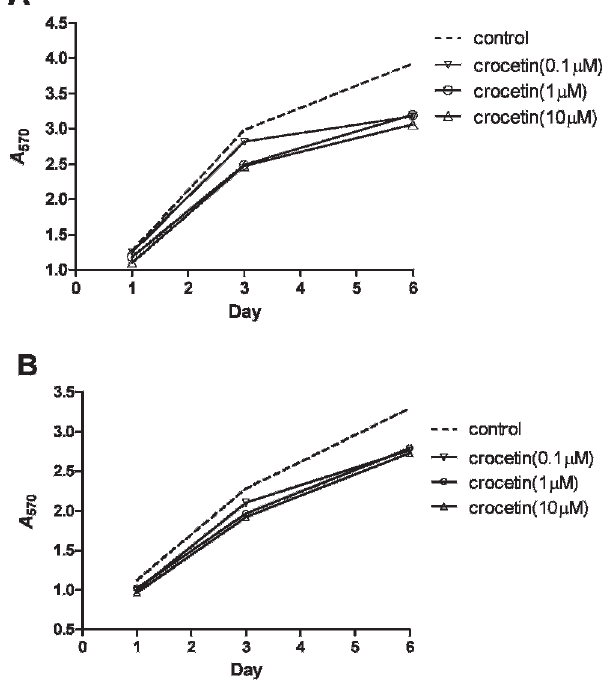
Figure 1 - Inhibitory effect of crocetin on the proliferation of fibroblasts derived from SSc patients and healthy individuals. Fibroblast proliferation was detected with the MTT assay, and absorbance at 570 nm was measured. (A) Proliferation of SSc fibroblasts. (B) Proliferation of normal